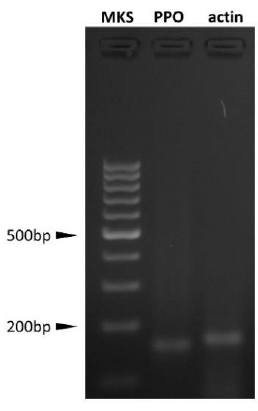
Figure 5. Prepro-orexin (PPO) and actin (ACT) expression in swine aortic endothelial cells (AOC). PPO expression was evaluated by nested PCR; the presence of PPO amplicon demonstrates gene expression but does not provide any information in comparison to ACT expression. Neither cell viability nor cell proliferation were influenced by OXB (Figure 6).